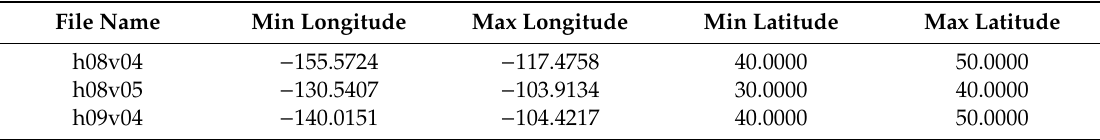
Table 2. Mosaic aerosol optical depth (AOD) files in hierarchical data format (HDF) covering the state of